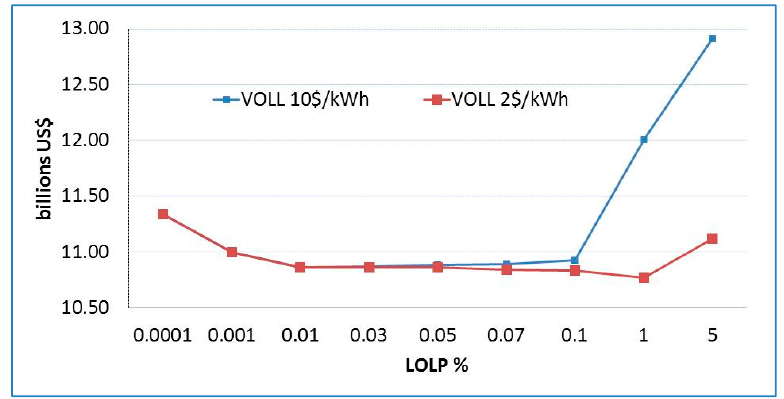
Figure 4. LOLP optimization for two VOLL levels in the case of combined cycle gas turbine (CCGT).